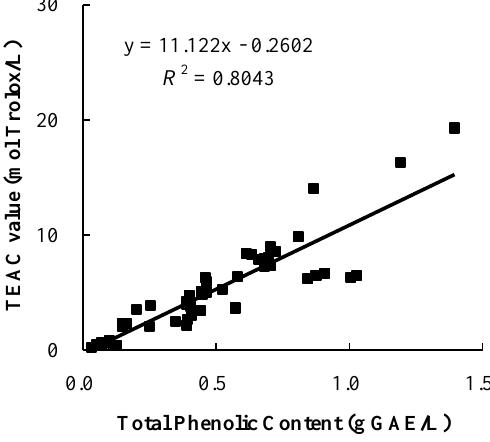
Figure 2. Correlation between total phenolic content and antioxidant capacities measured by the TEAC assay. GAE: Gallic acid equivalents.